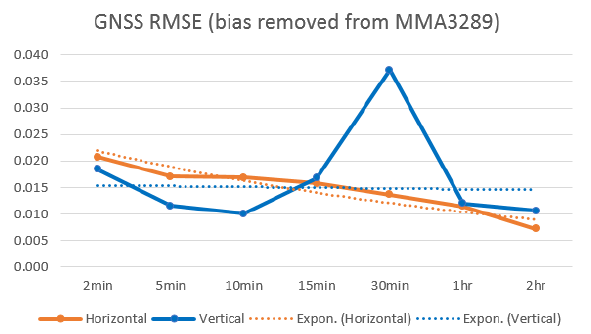
Figure 13. RMSE of horizontal and vertical observations using BeiDou only. Y-axis in meters.